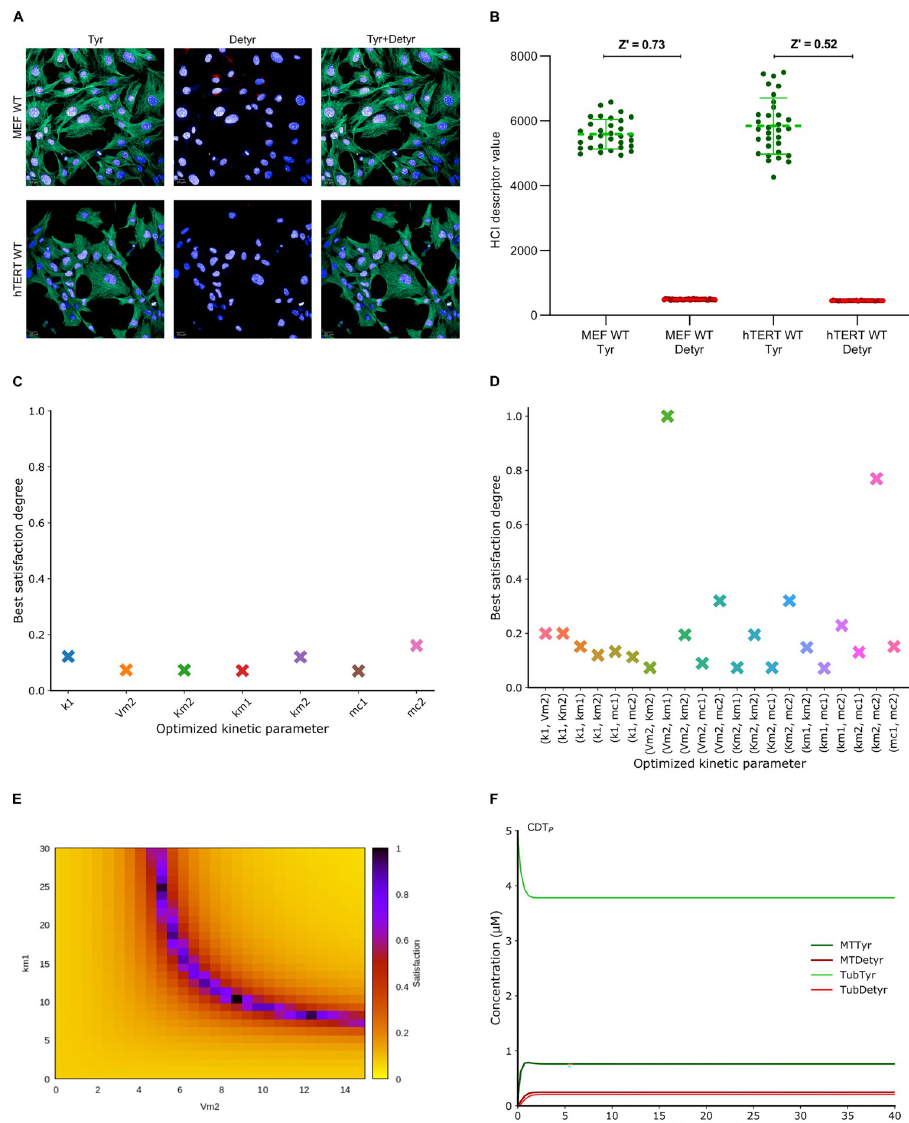
Fig 2. Parameterization of the computational model CDT P with HCI quantification combined with BIOCHAM parameter optimization procedures. ( A ) Representative images of immunostaining of tyrosinated tubulin (Tyr) in green, detyrosinated tubulin (Detyr) in red in MEF cells and hTERT RPE-1 cells (left). Cells were co-stained with Hoechst. Scale bars: 20 μ m. (B) Quantification of the tyrosination status by high-content imaging (Right). Tubulin and microtubule are predominantly observed in tyrosinated form (Z’-factor > 0.5). The plotted values are the average of single-cells values ± SD. (C) Best satisfaction degree obtained by the parameter search procedure by varying only one kinetic parameter independently, showing failure to reproduce the observed behaviour. The BIOCHAM command used is: search_parameters(F(Time == 5 /\ Tyr = factor1 � Detyr /\ F(Time == 20 /\ Tyr = factor2 � Detyr)), [0 <= p <= 100], [factor1 -> 10, factor2 -> 10]) where p is the kinetic parameter to optimize. (D) Best satisfaction degree obtained by the parameter search procedure by varying couples of two kinetic parameters simultaneously, showing perfect satisfaction of the specification with one couple of parameters only: ( V m 2 , k m 1 ). The BIOCHAM command used is: search_parameters(F(Time == 5 /\ Tyr = factor1 � Detyr /\ F(Time == 20 /\ Tyr = factor2 � Detyr)), [0 <= p1 <= 100, 0 <= p2<= 100], [factor1 -> 10, factor2 -> 10]) where p1 and p2 are two kinetic parameters to optimize. (E) Landscape of the satisfaction degree obtained by scanning the parameter values of the couple ( V The BIOCHAM command used to obtain the landscape is: scan_parameters(F(Time == 5 /\ Tyr = factor1 � Detyr /\ F(Time == 20 /\ Tyr = factor2 � Detyr)), (0 <= Vm2 <= 15), (0 <= km1 <= 30), [factor1 -> 10, factor2 -> 10], resolution:30)